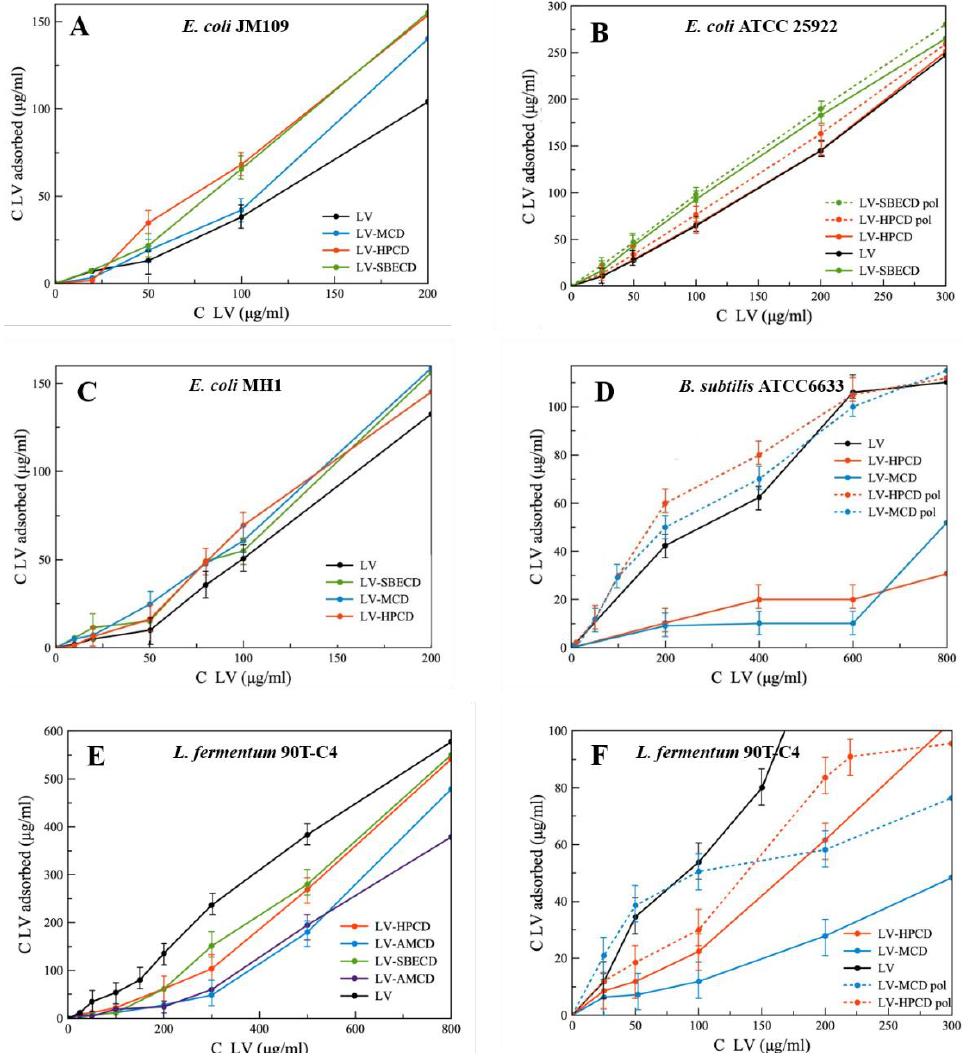
Figure 7. The absorption curves of LV, LV–CD and LV-CDpol on bacterial strains, ~1 × 10 9 cells/mL, pH 7.4 (0.02 M Na-phosphate buffer solution), 1 h of incubation, 37 °C. ( A ) E. coli JM109; ( B ) E. coli ATCC 25922; ( C ) E. coli MH1; ( D ) B. subtilis ATCC6633; ( E ) Lactobacillus fermentum 90T-C4; ( F ) Lactobacillus fermentum